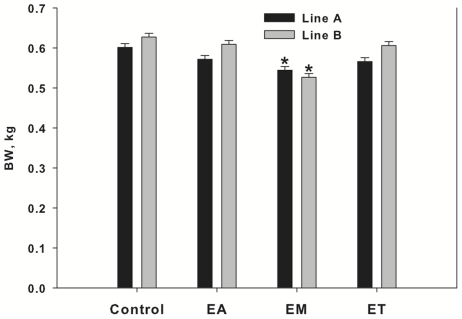
Body weights at Day 21 for Line A and B birds infected with 1 of 3 Eimeria strains.Birds were inoculated at day 15 with vehicle (control.), E. acervulina (EA), E. maxima (EM) or E. tenella (ET). A. = Line A, B. = Line B. Bars represent means ± pooled SEM. Asterisks represent difference from respective control group within genetic line (P<0.01).